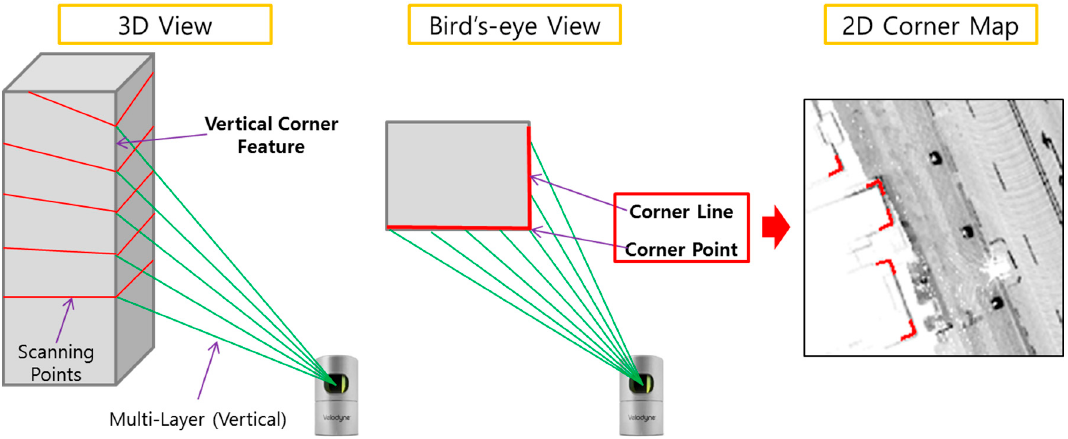
Figure 1. Corner definition.